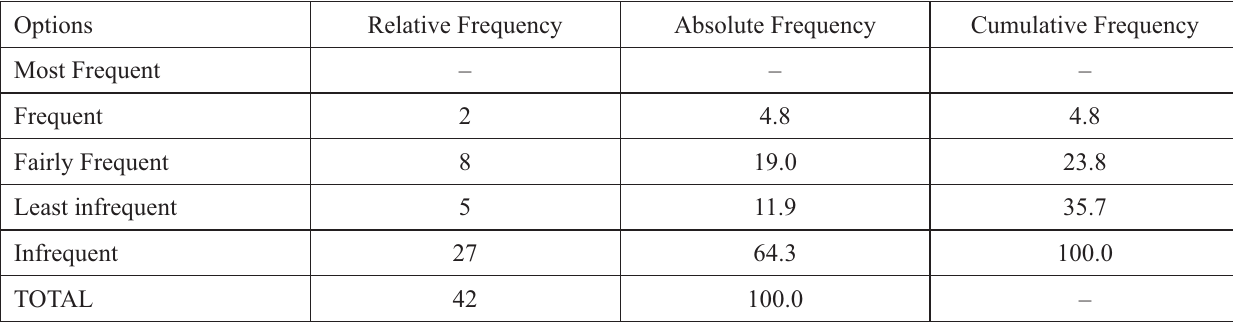
Table 5. Frequency of Auction Sales by respondent lending